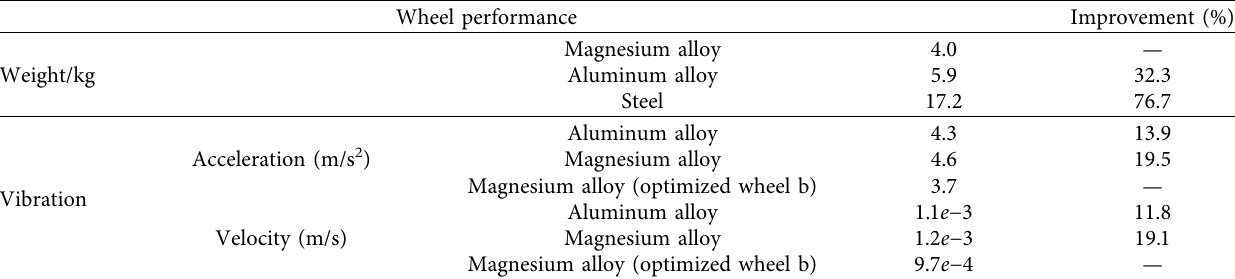
Table 4: Comparison of wheel